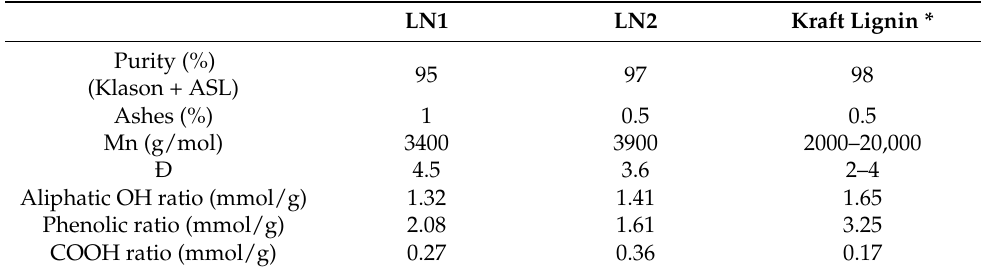
Table 1. Main characteristics of Rayonier AM alkaline